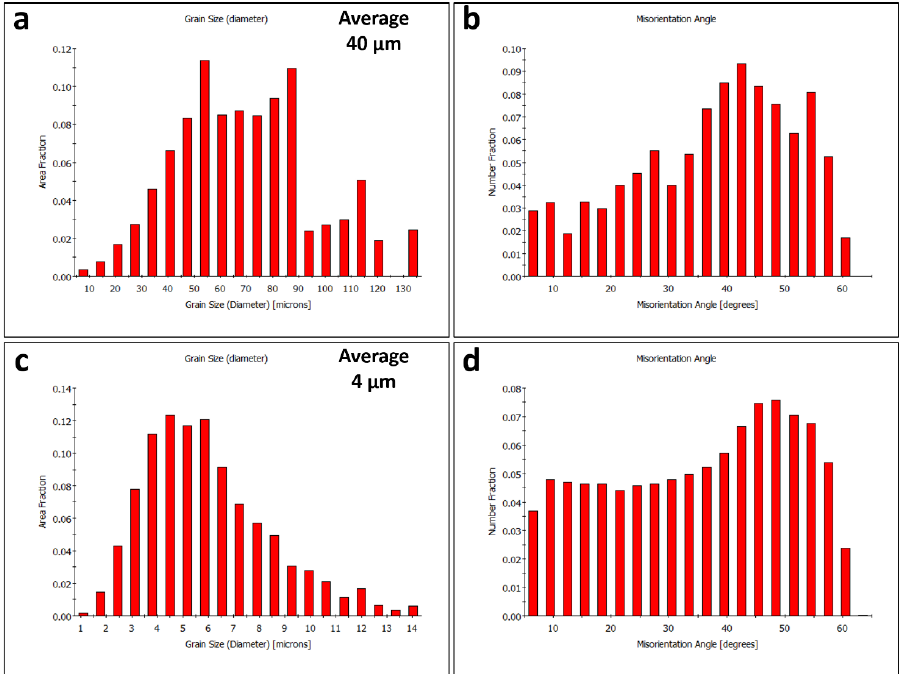
Figure 17. Histogram distributions of grain size and misorientation angle obtained from the OIM data given in Figure 18 for the AA5052-H32 BM ( a , b ) and the SZ after the FSSWed joint processed at 2 s and 500 rpm ( c , d ).